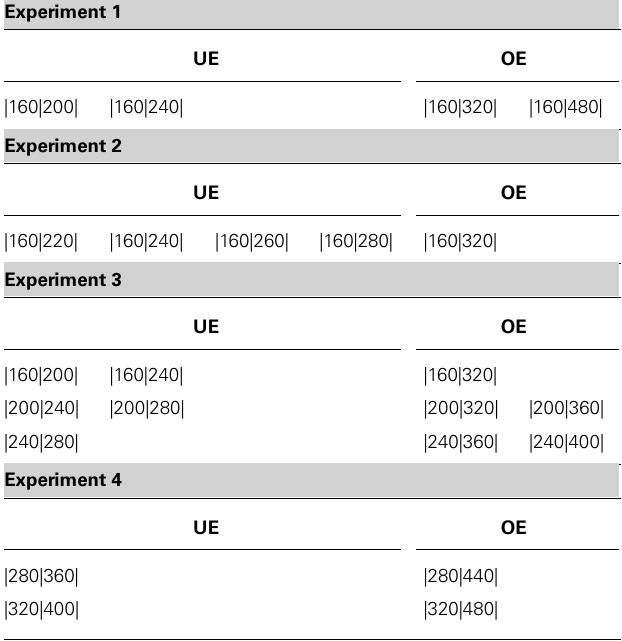
Table 2 |Temporal patterns in which time shrinking was replaced by overestimation in Nakajima etal.